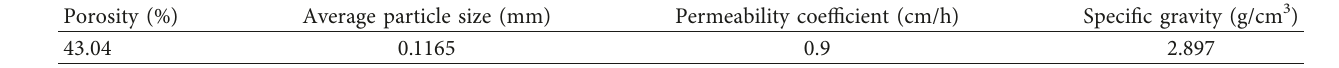
Table 1: Physical property parameters of